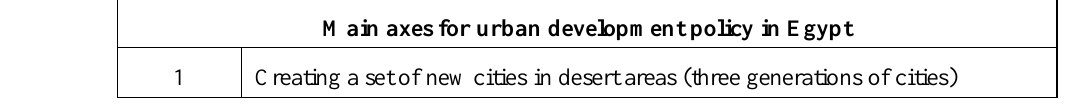
Main axes for urban development policy in Egypt 1 Creating a set of new cities in desert areas (three generations of